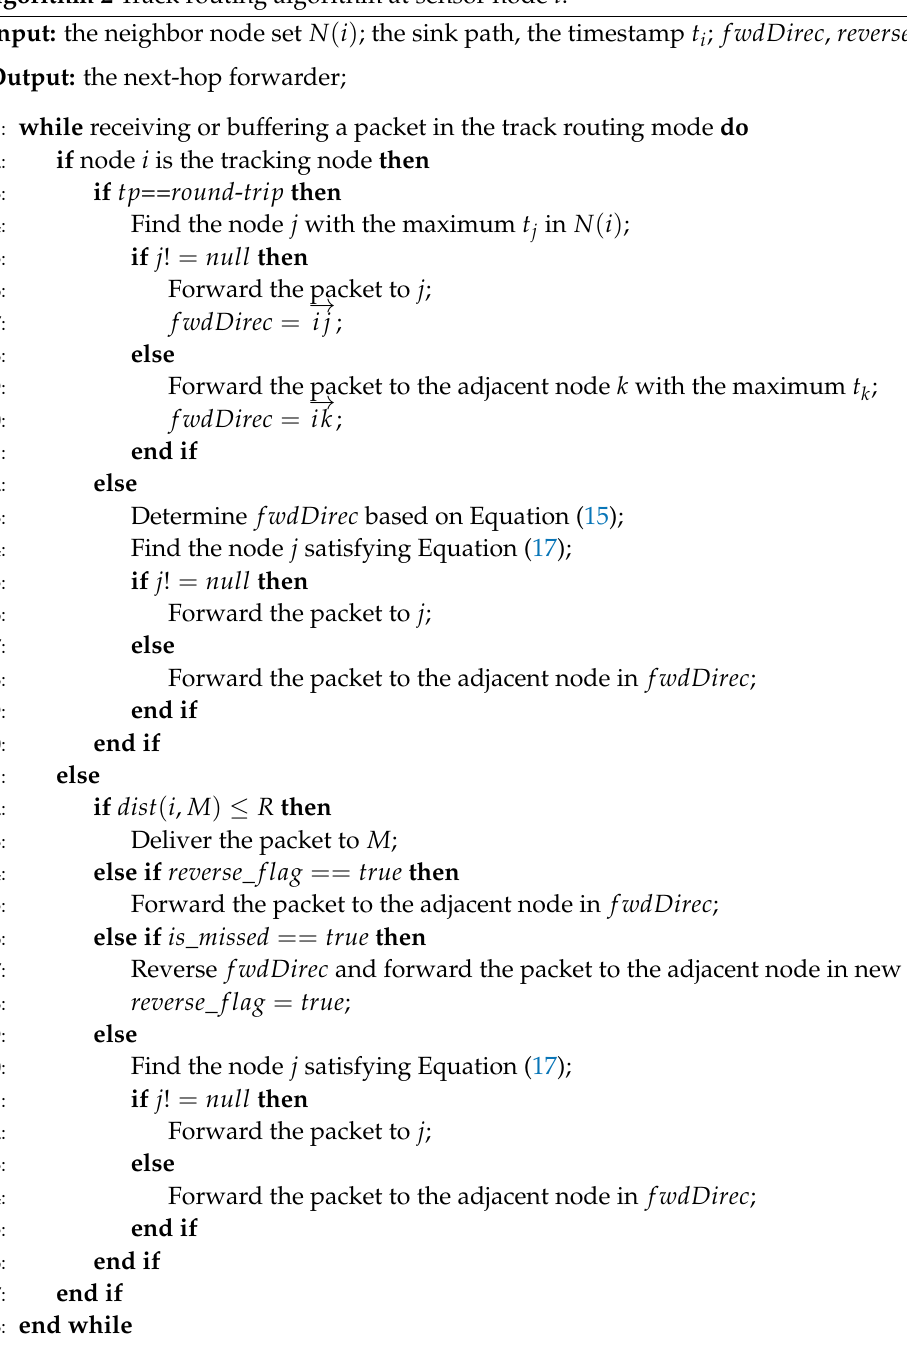
Algorithm 2 Track routing algorithm at sensor node i